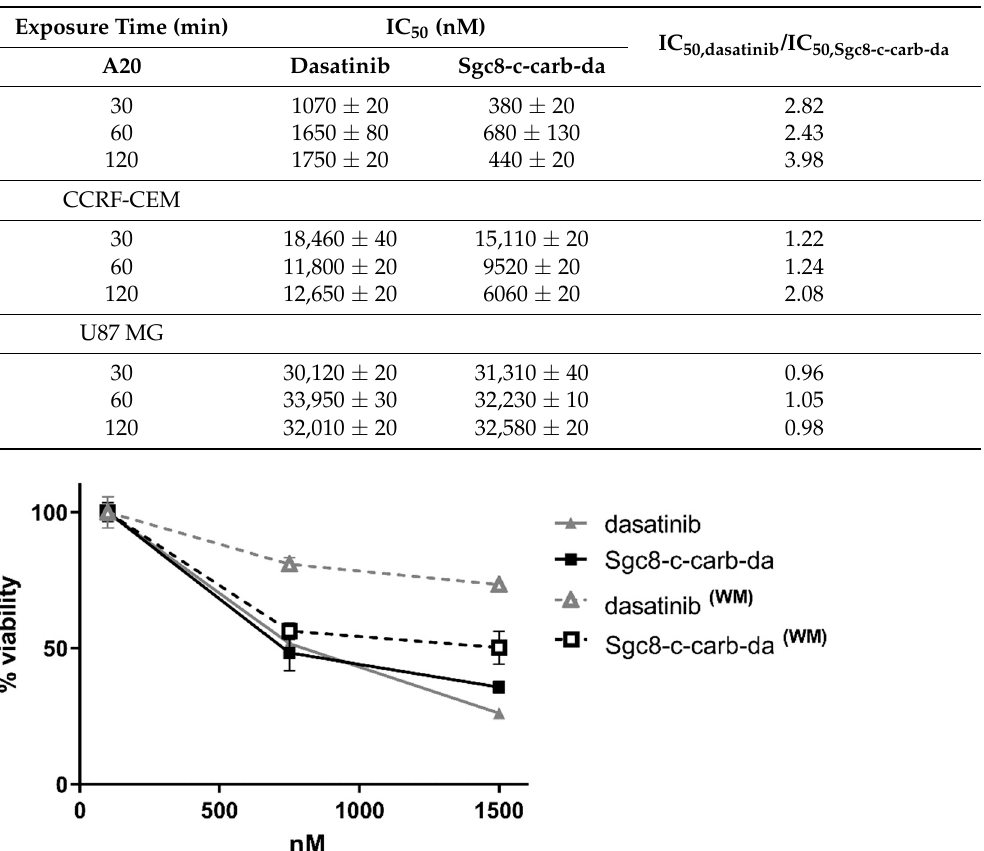
Table 2. Cytotoxic effects of dasatinib and Sgc8-c-carb-da against A20 cells, PTK7-positive CCRF- CEM, and negative U87 MG controls after different drug exposure times, expressed as IC 50 .